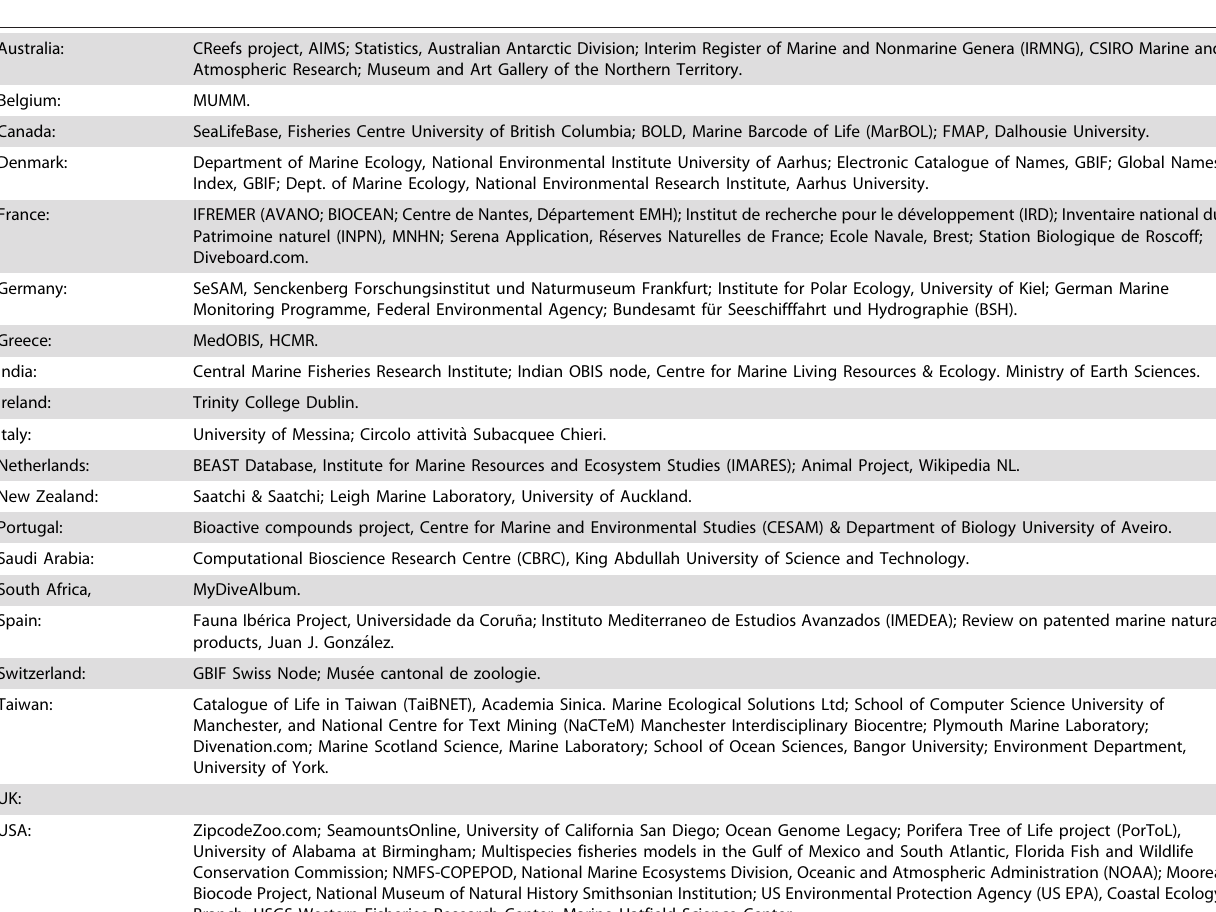
Table 9. Organisations with licensed copies of WoRMS for their research and/or data management.